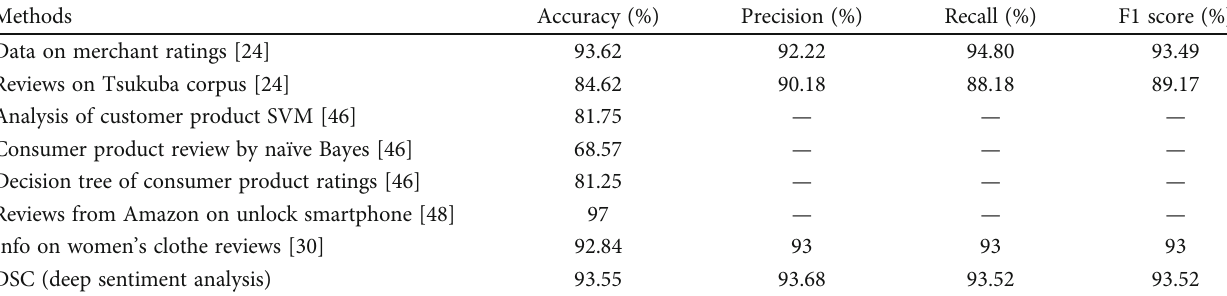
Table 11: Summary of key performance indicators compared to existing methods based on sentiment classi fi cation.